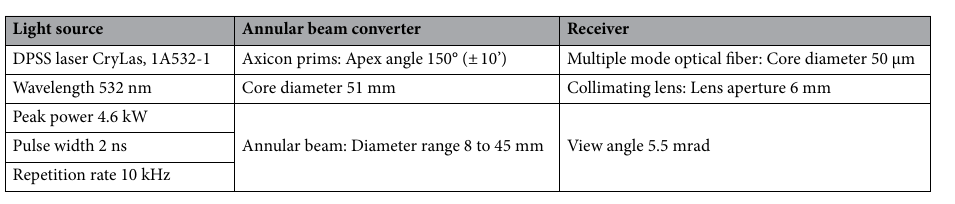
Table 1. Specification of the experiment